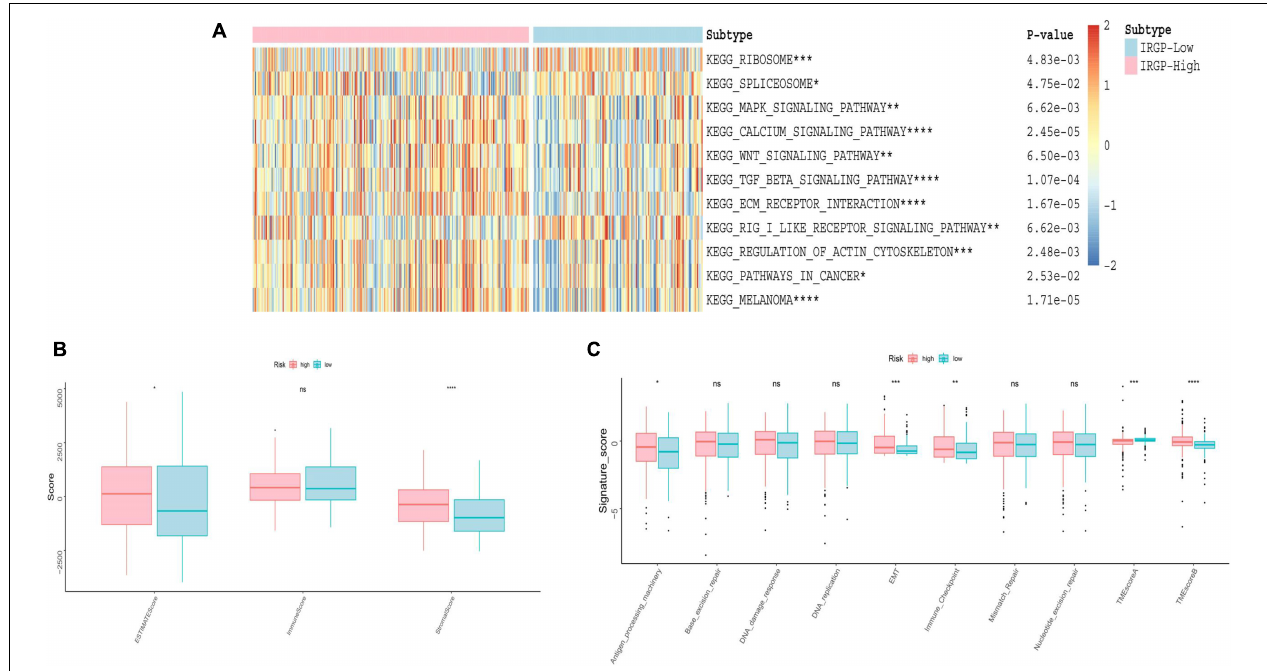
FIGURE 5 | Evaluation of differences in TME between two risk groups. (A) Heat map of GSVA analysis between two risk groups. (B) Boxplot of immune score and stromal score from ESTIMATE. (C) Boxplot of Evaluating novel TME score. EMT, epithelial mesenchymal transition; TME, tumor microenvironment. * P < 0.05, ** P < 0.01, *** P < 0.005, **** P < 0.001, ns, no